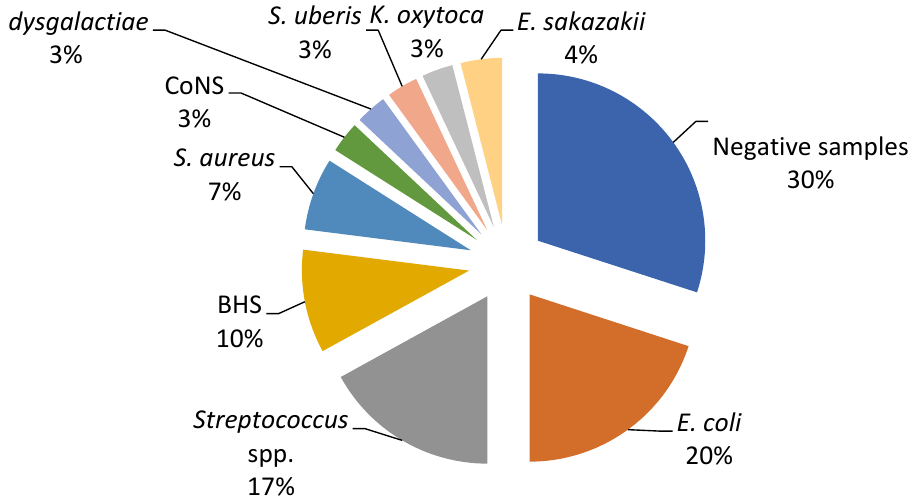
Figure 1. Percentage ratio of bacterial strains in the collected milk samples on Farm A.